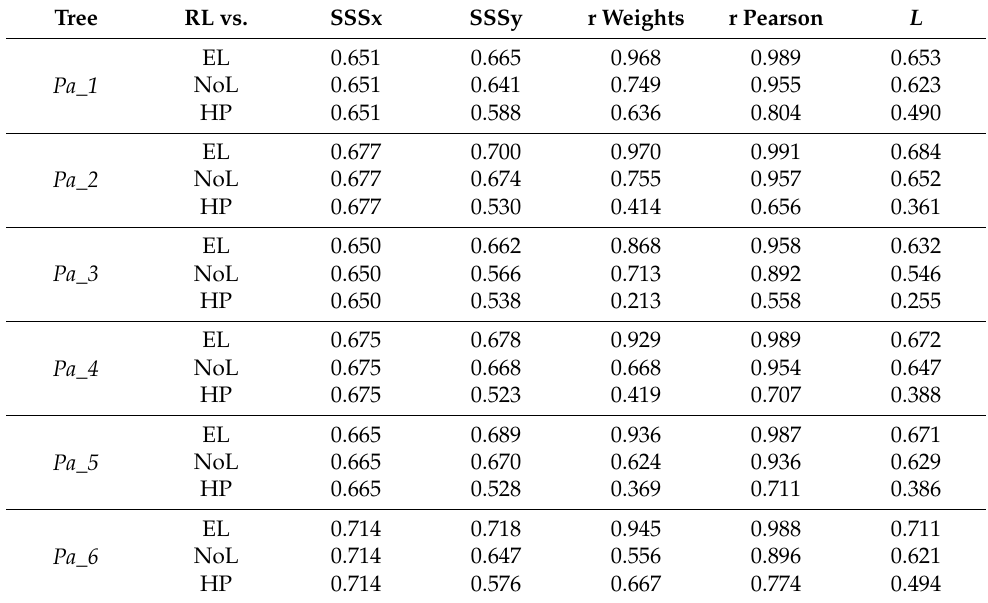
Table 5. Spatial association measures and correlation coefficients for paired-observations (RL with other modes) and stats. Tree RL vs. SSSx SSSy r